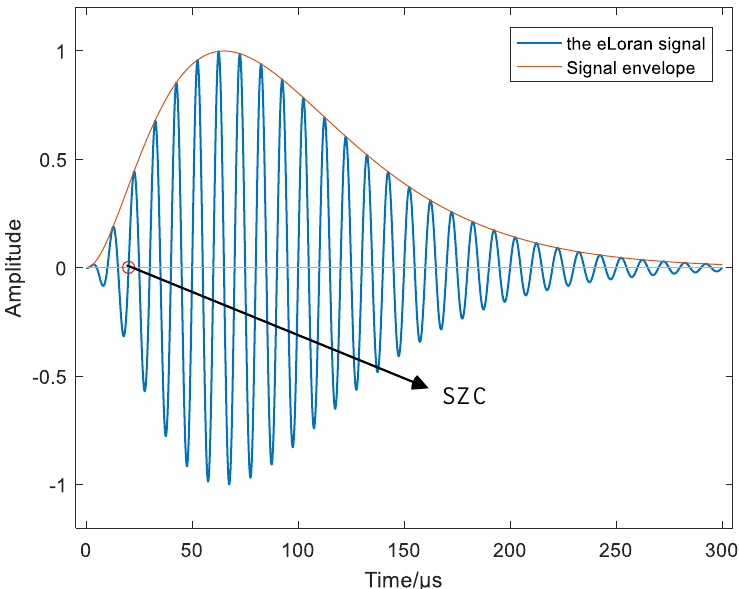
Figure 1. The enhanced long-range (eLoran) pulse shape. The red dot represents standard zero-crossing (SZC), which is the point at which the signal is tracked by an eLoran receiver and it is used to calculate time-of-arrival.